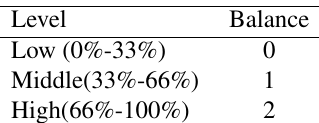
Table 2. Sub intervals balance